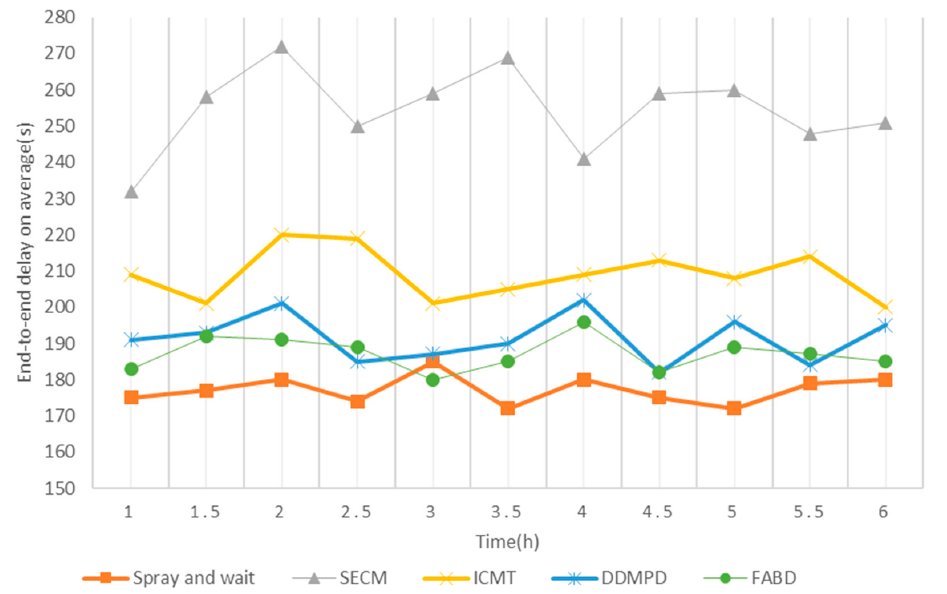
Figure 7. The relationship between end-to-end delay and